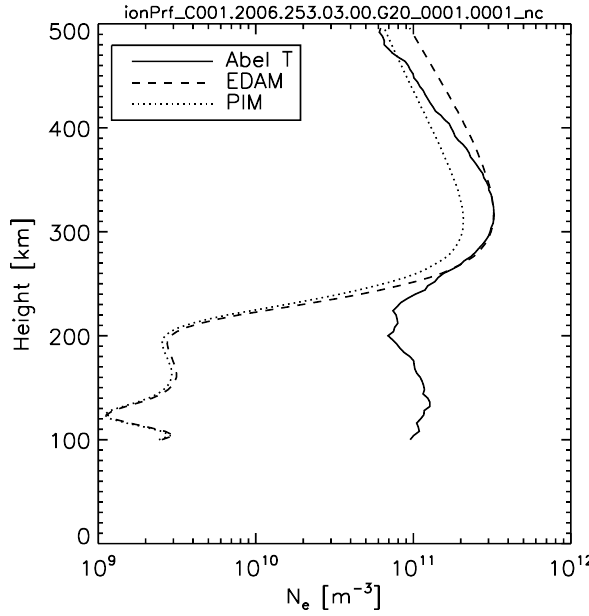
Fig. 7. Example comparison between PIM, EDAM and Abel Trans- form vertical electron density profiles.